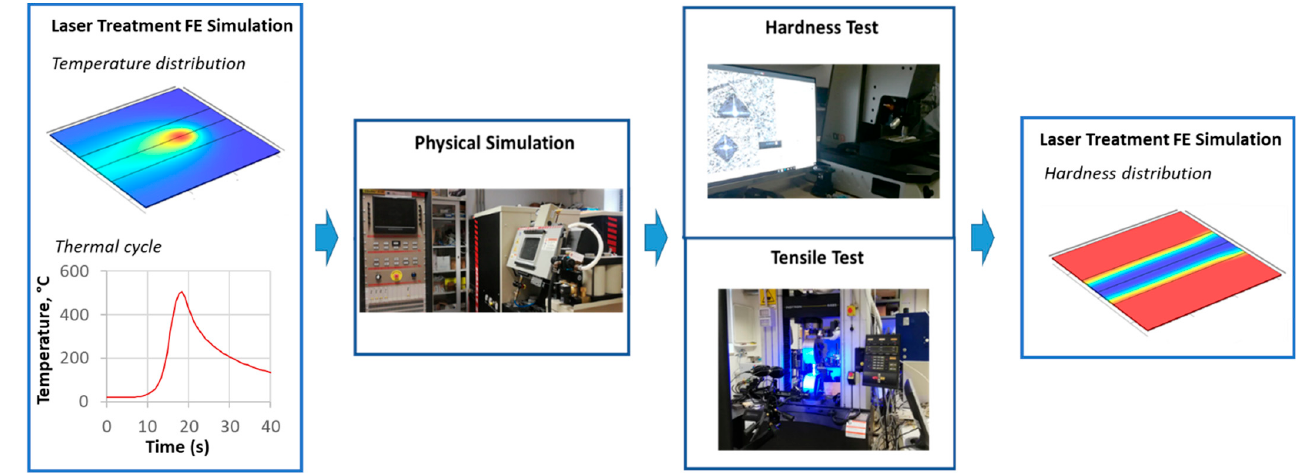
Figure 1. Schematic description of adopted methodology.